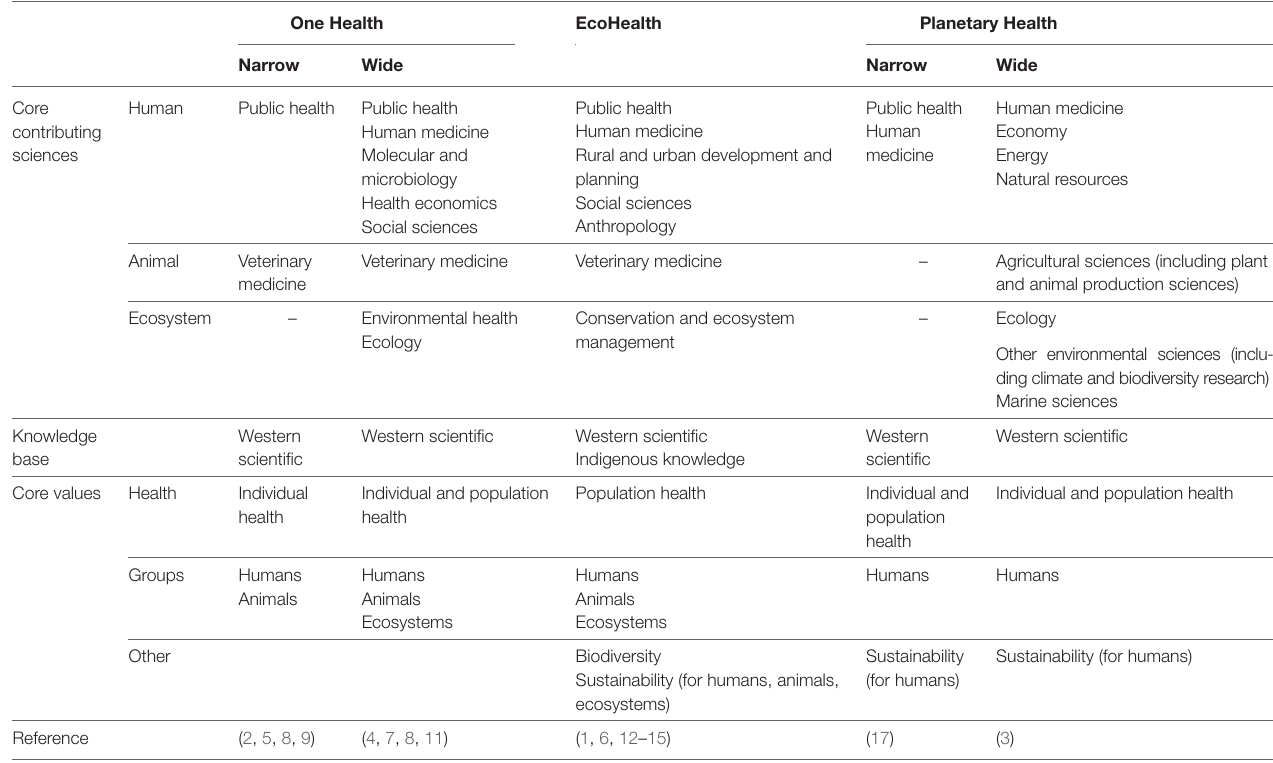
tAbLe 1 | Comparison of the three